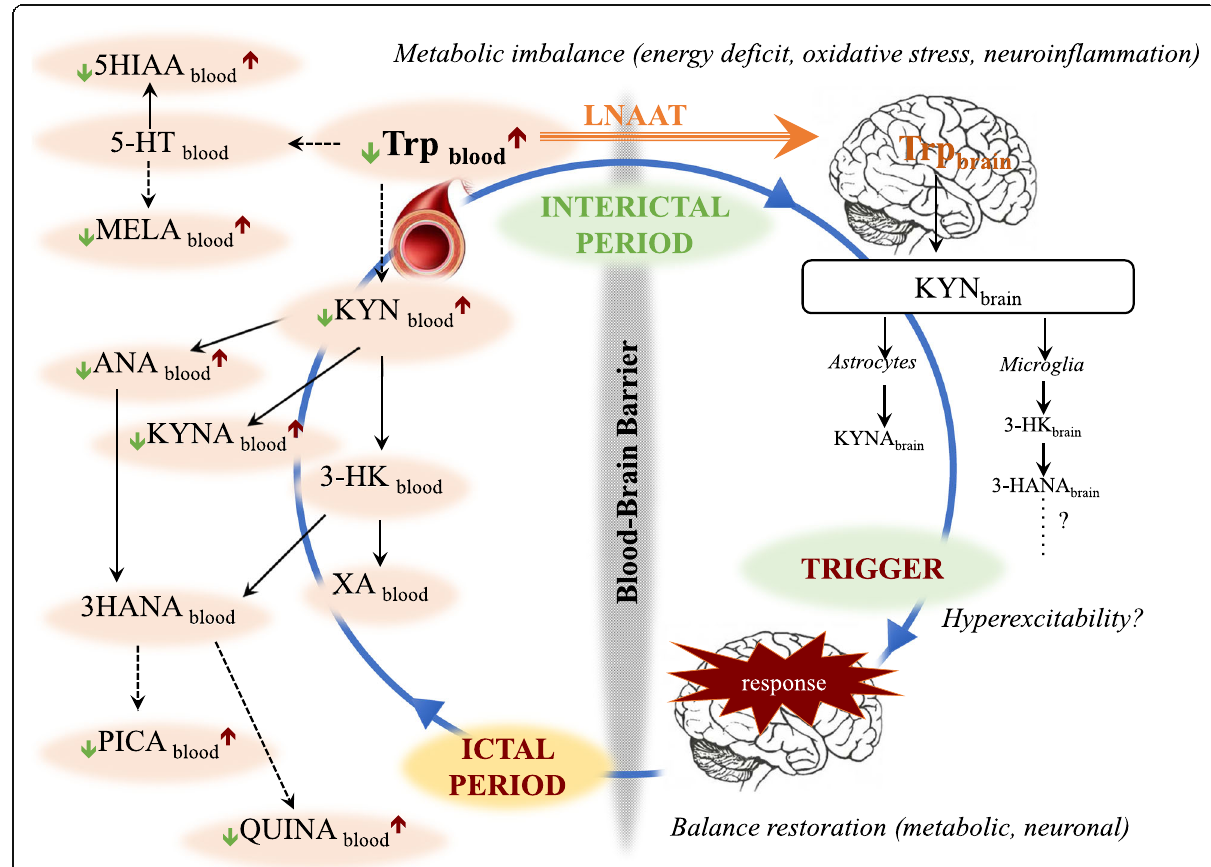
Fig. 6 Scheme of altered Trp catabolism and potential mechanisms during interictal/ictal periods in episodic migraineurs. LNAAT: large neutral amino acid transporter, Trp: Tryptophan, 5-HT: 5-hydroxytryptamine, 5-HIAA: 5-hydroxy-indoleaceticacid, MELA: Melatonin, KYN: L-kynurenine, KYNA: Kynurenic acid, ANA: Anthranilic acid, 3-HK: 3-hydroxykynurenine, XA: Xanthurenic acid, 3-HANA: 3-hydroxy-anthranilic acid, PICA: Picolinic acid, QUINA: Quinolinic acid. Continuous arrow: direct step in the pathway, Dashed arrow: indirect step in the